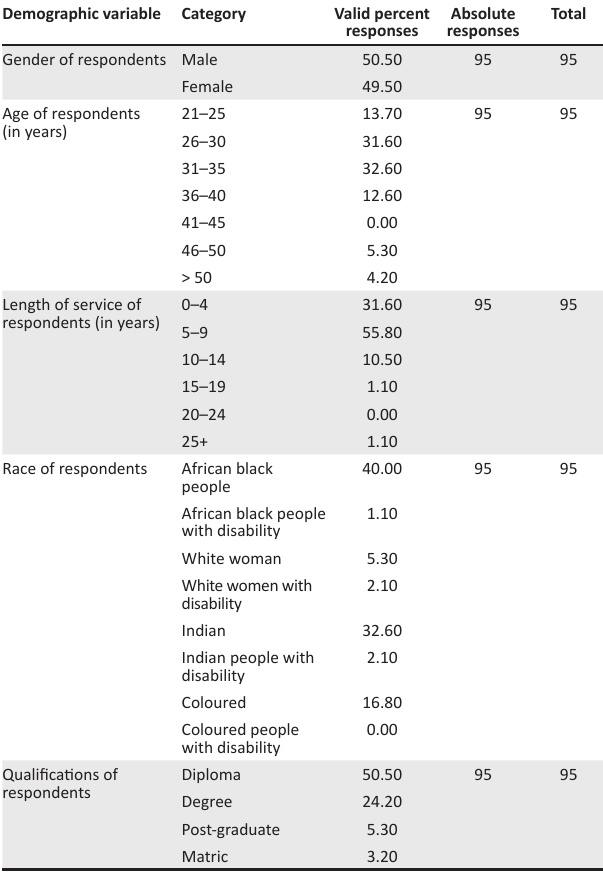
TABLE 3: Analysis of demographic data of the respondents ( n = 95). Demographic variable Category